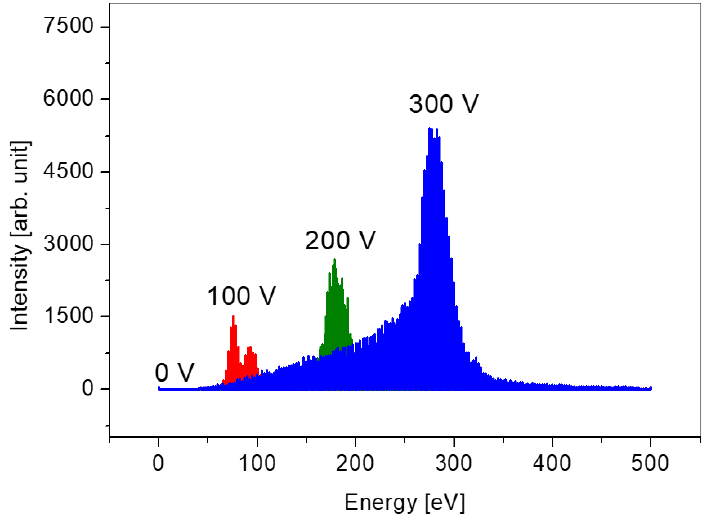
Figure 4. Ion energy distributions for extractor voltages of 0, 100, 200, and 300 V under a constant spu(cid:308)er voltage of −550 V.